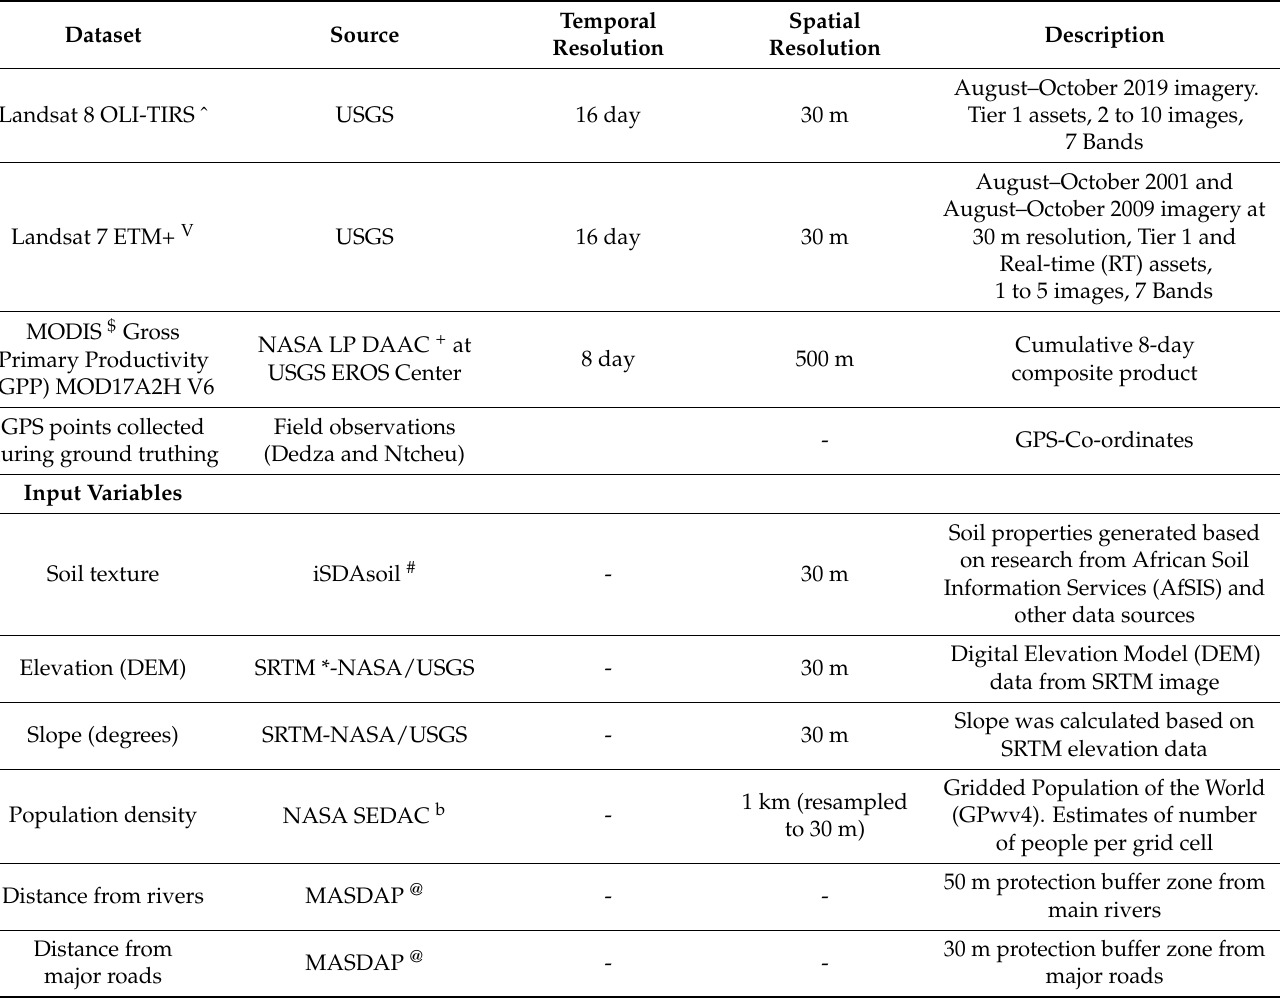
Table 1. Satellite Datasets used for land-cover classification and input spatial variables used for LULC change